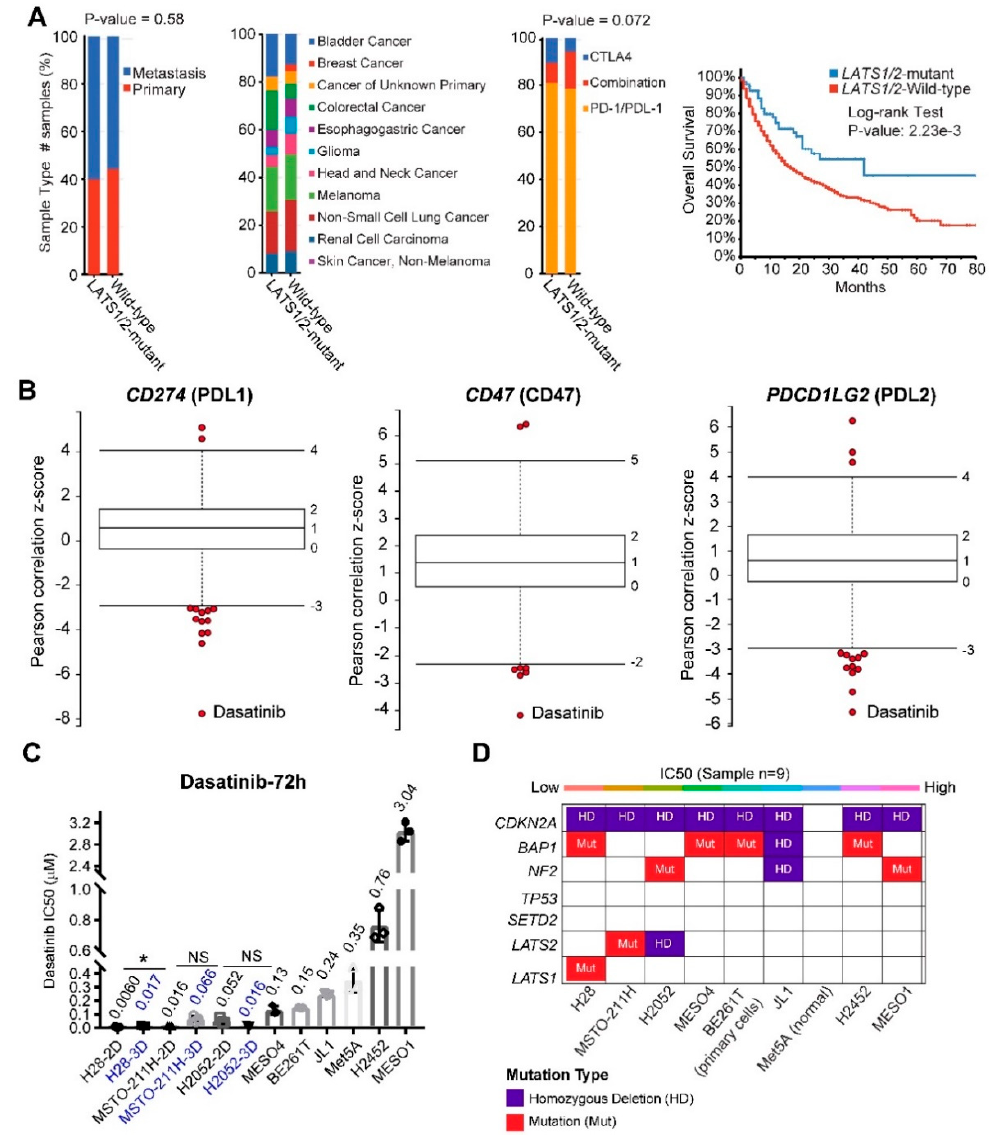
Figure 6. Identify Dasatinib as a promising therapeutic drug for MPM with LATS2 alterations. ( A ) LATS1/2 mutational status is associated with significantly improved overall survival in cancer patients after immune checkpoint blockage. The distribution of sample type (primary vs. metastatic; left panel), cancer type (middle panel) and drug type (anti-CTLA4; anti-PD1/PDL1; right panel) between LATS1/2 -mutant and wild-type cancer. ( B ) Box-and-whisker plots show the extent of correlation between cytotoxic effects of Dasatinib and with several well-characterized immune markers (PDL1, PDL2, CD47), preferentially expressed by cancer cells. The y-axis indicates z scored Pearson’s correlation coefficients; line, median; box, 25–75th percentile; whiskers, 2.5th and 97.5th percentile expansion; Here, only significantly ( p < 0.05) correlated inhibitors were shown (in red dots). Notably, Dasatinib is the most negatively correlated drug. ( C , D ) the median inhibitory concentration (IC50) values of a panel of MPM cell lines treated with Dasatinib (72 h). MPM cells seeded in triplicate at 96-well plates were drugged 24 h later, over a 12-point concentration range (two-fold dilution). DMSO-treated cells were used as control. IC50 was determined using GraphPad Prism 7. IC50 values of Dasatinib in three MPM cell lines (H28, MSTO-211H, H2052) cultured in 2D and 3D were compared. * p < 0.05 by Welch’s t -test. N = 3 biological replicates. In D, the genetic annotations of MPM cell lines ( C ) were shown.